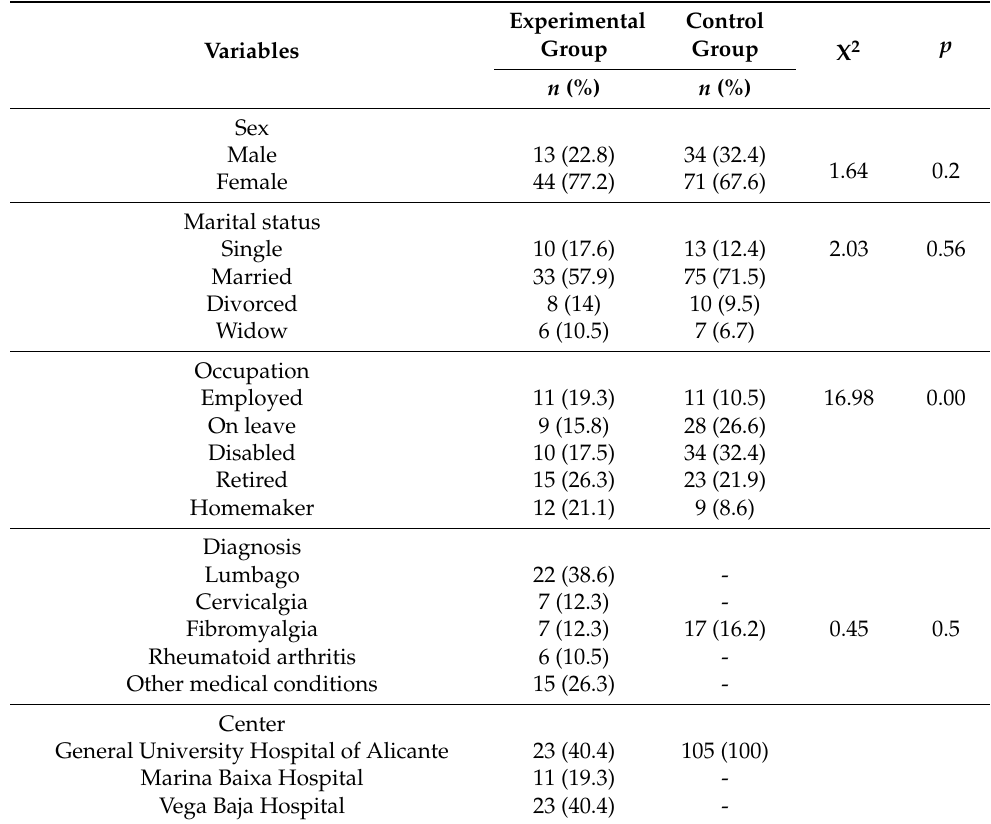
Table 2. Sociodemographic characteristics, medical diagnoses, and participating centers of the experimental and control groups. Differences in frequencies between both groups were determined by Chi-square